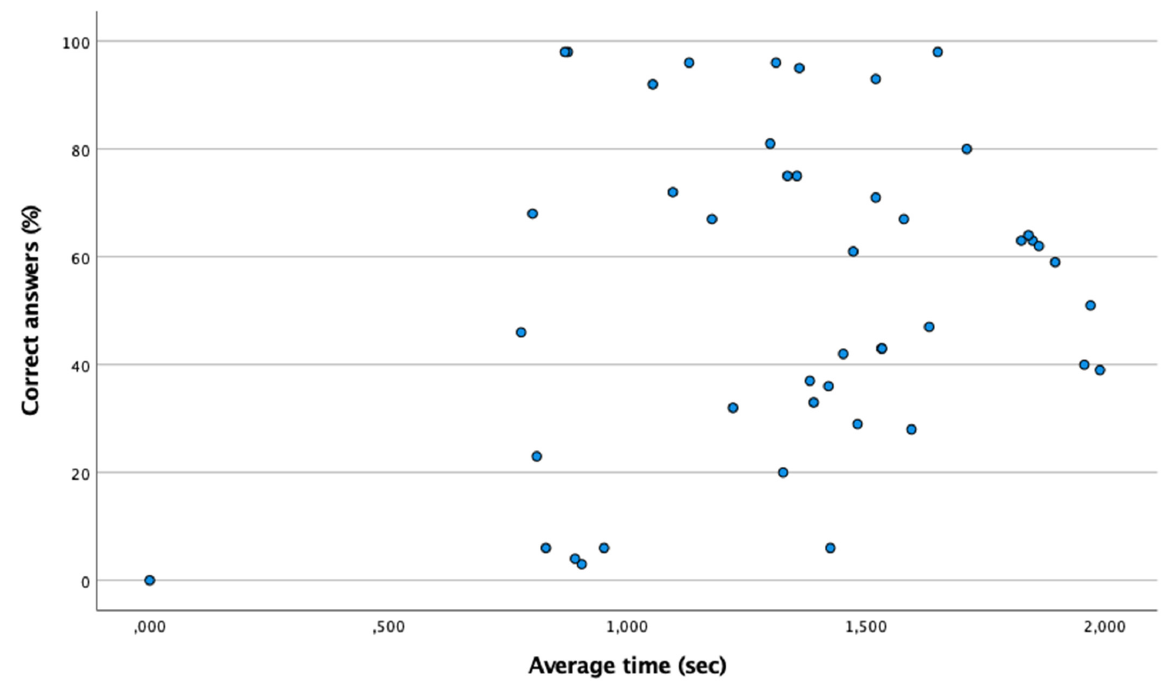
Figure 4. Absence of relationship between the percentage of correct answers and the mean time in the coordination and identification test. The point (0,0) means that there is no correct answer.